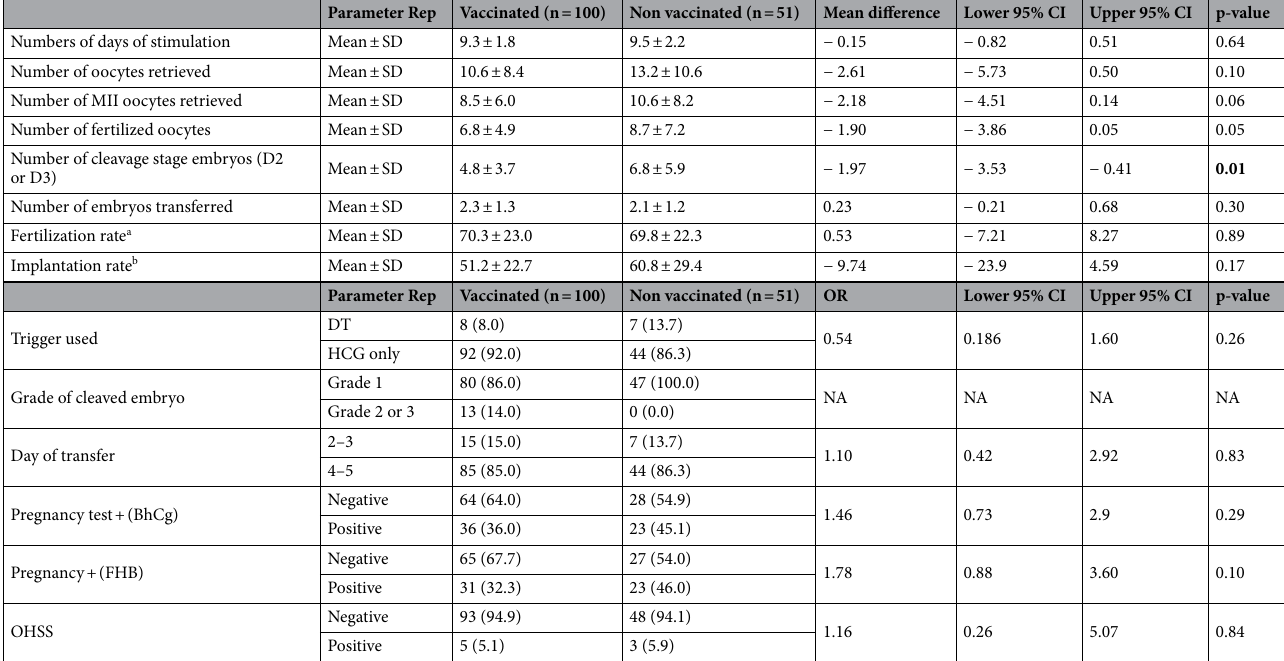
Table 3. Vaccine and IVF treatment outcome parameters. SD standard deviation, DT dual trigger, BhCG beta human chorionic gonadotropin, HCG human chorionic gonadotropin, OHSS ovarian hyper-stimulation syndrome, OR Odds ratio, CI Confidence interval. a Fertilization rate is defined as the percentage of fertilized oocytes from the collected oocytes. b Implantation rate is calculated as the number of gestational sacs observed per number of embryos